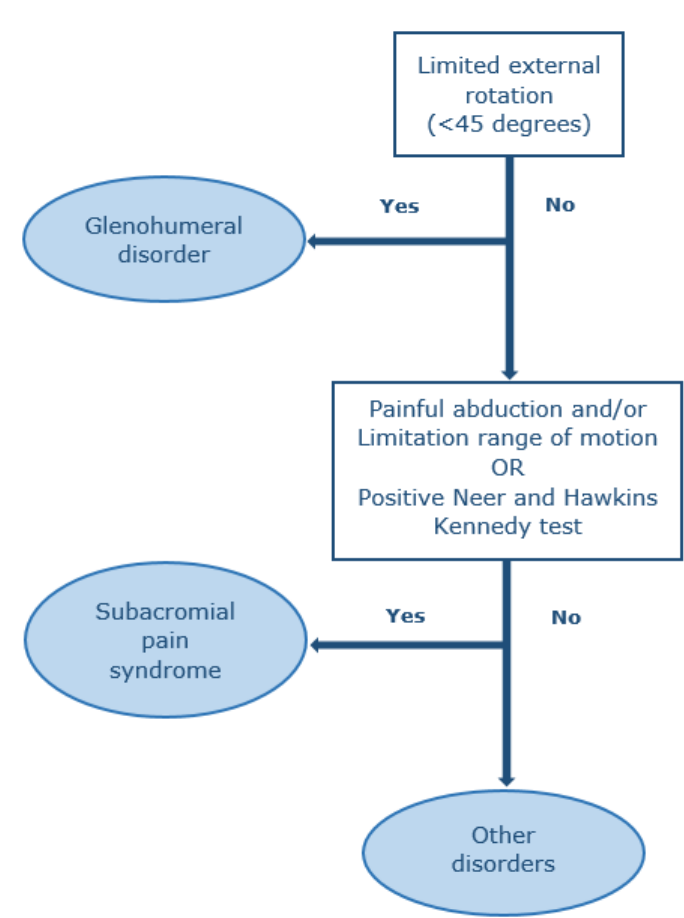
Figure 1. Diagnosis based on physical examination by a mutually excluding method.